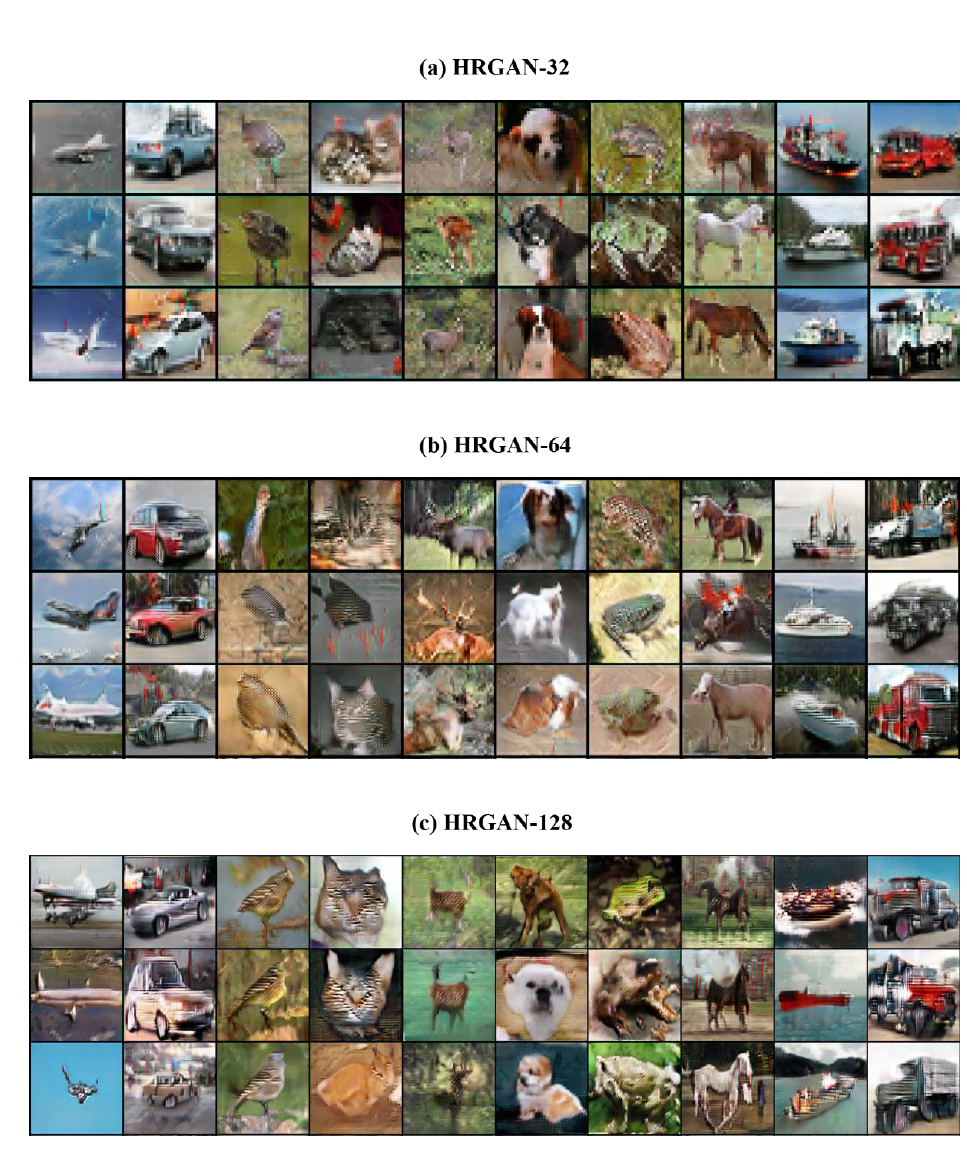
Figure 5. Randomly generated image samples of CIFAR10 by HRGANs with different resolutions.